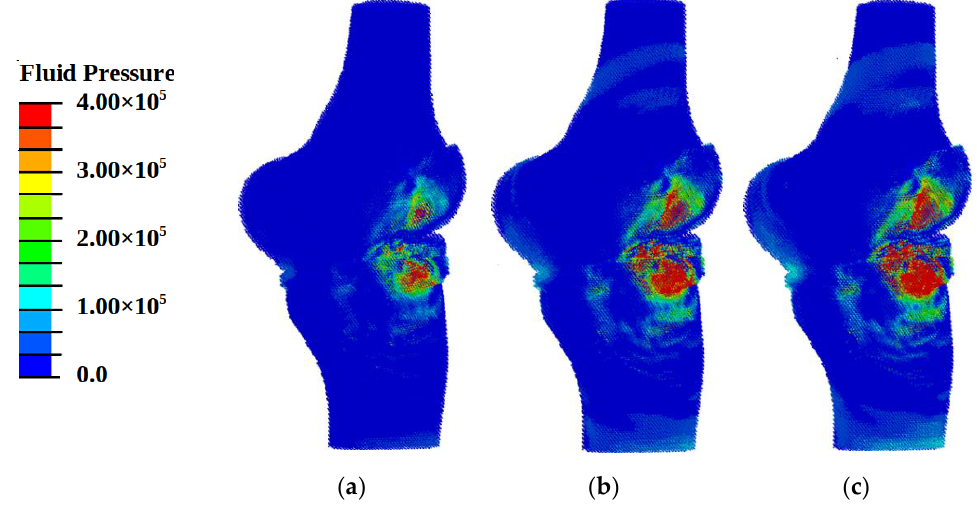
Figure 8. Fields of fluid pressure (Pa) in pores at different energy flux density of shock wave: ( a ) 0.12 mJ/mm 2 ; ( b ) 0.33 mJ/mm 2 ; ( c ) 0.8 mJ/mm 2 .